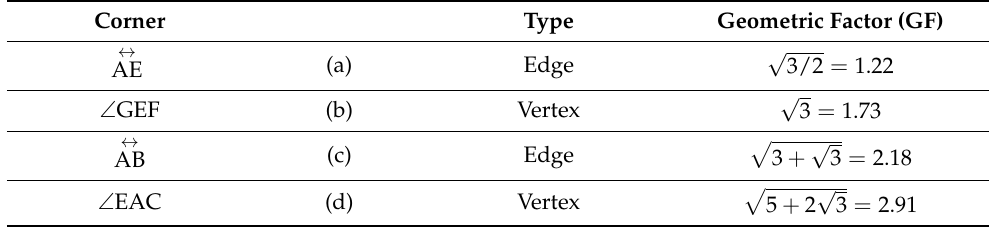
Table 1. Overview of the corner types and corresponding geometric factor. The letters in the Corner column correspond to those in Figure